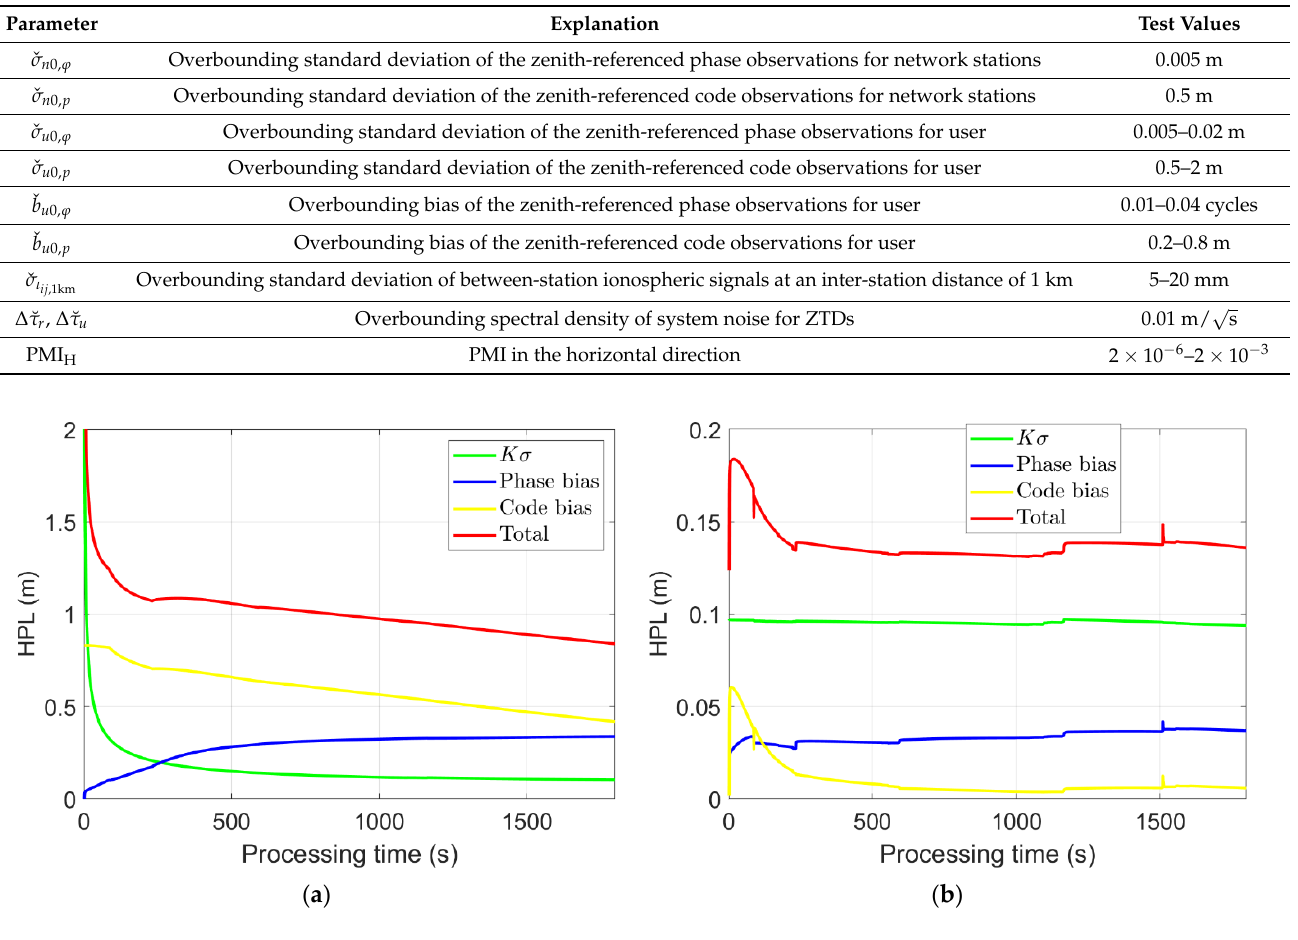
Table 7. Overbounding parameters used for different categories of the multipath environments and ionosphere conditions.